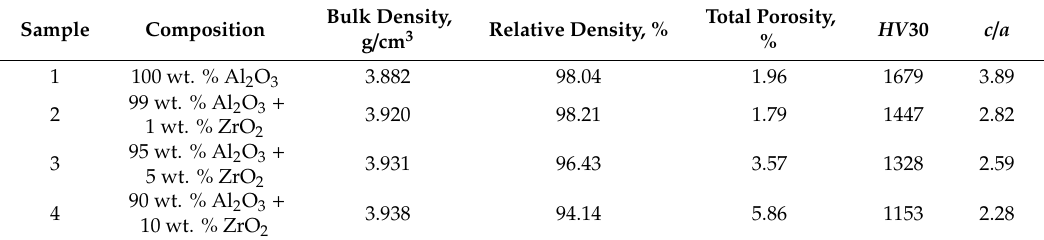
Table 7. The density, porosity and hardness of Al 2 O 3 and Al 2 O 3 -ZrO 2 samples and the c / a ratio. Where, c is the crack length from the center of the indentation to the crack tip in m and a is a half of the indentation